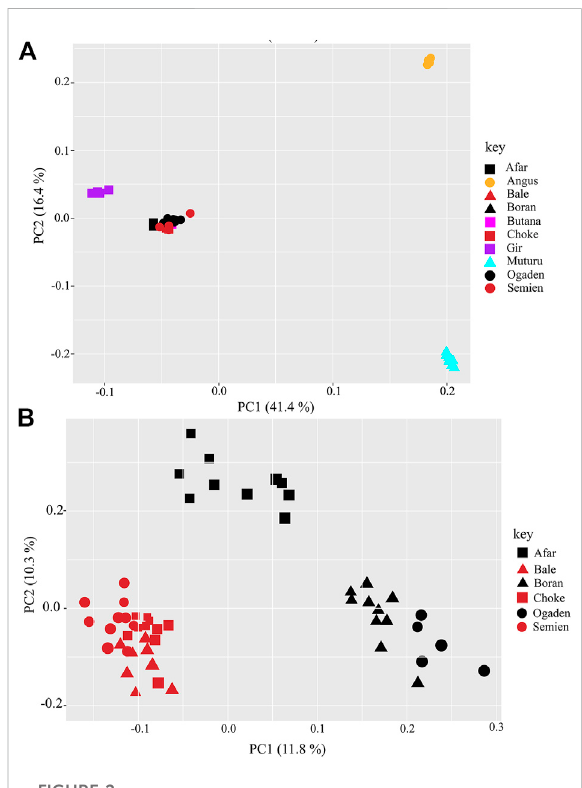
FIGURE 2 A plot of the fi rst and second principal components (PC1 and PC2) of (A) the whole population dataset and (B) Ethiopian high altitude (brown color: Bale, Choke, and Semien) and low altitude (black color: Afar, Boran, and Ogaden) cattle